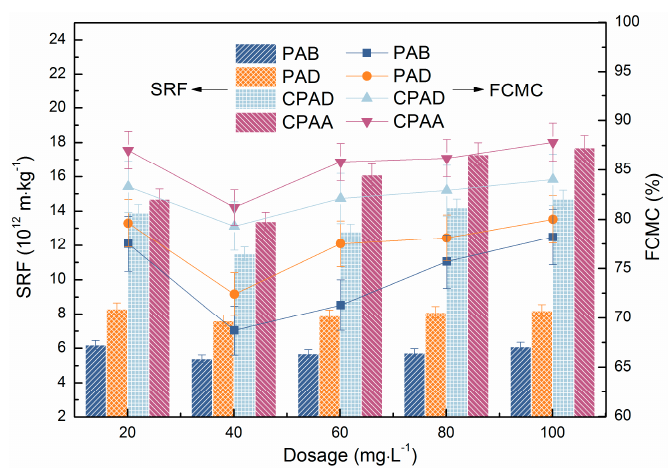
Figure 8. Effect of flocculants dosage on specific resistance to filtration (SRF) and filter cake moisture content (FCMC).